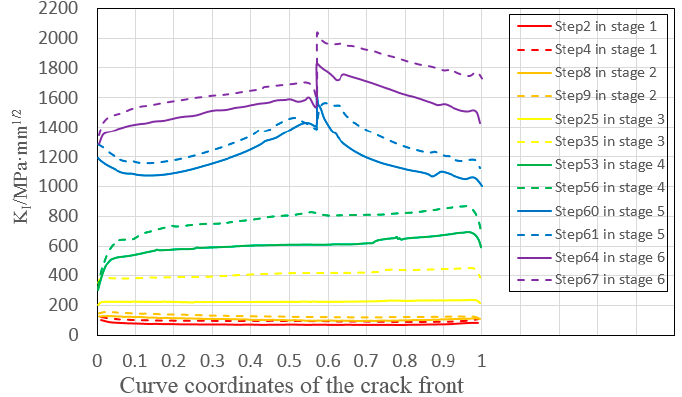
Figure 15. K I distribution of the crack front in different stages ( K equ + SERR).